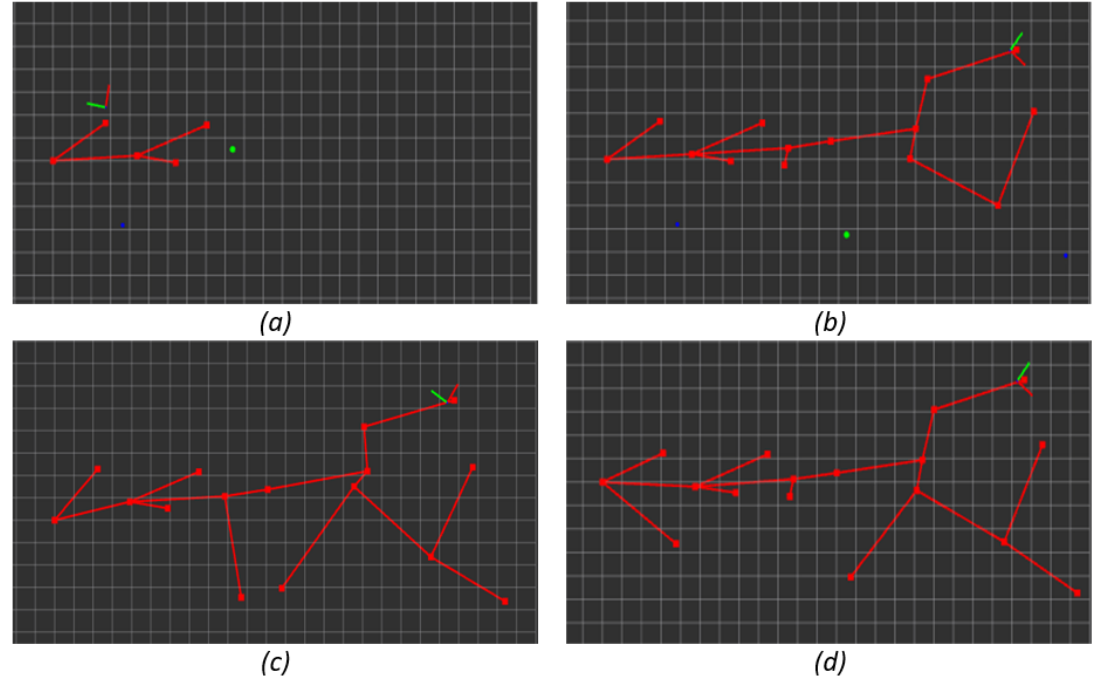
Figure 6. Topological map for different minimum interesting function values: ( a ) minimum value 80; ( b ) minimum value 40; ( c ) minimum value 30; and ( d ) minimum value